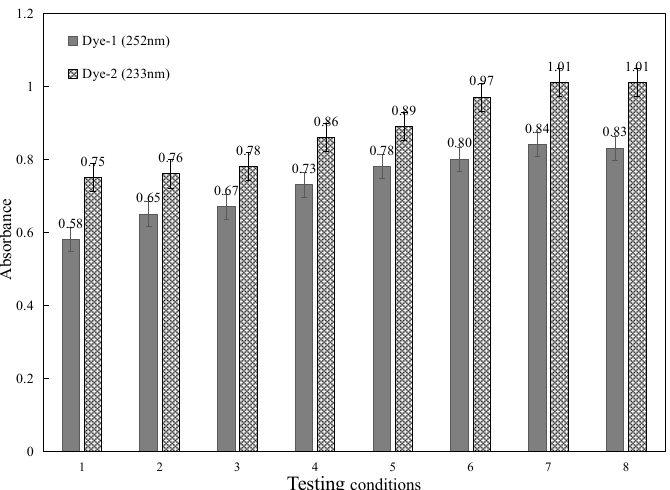
Figure 2. Detection of abs in simulated dyeing experiments. Please note: 1-Mixing of 0.0005 mol dye and 0.0005 mol n -butanol at room temperature. 2-Reaction of 30 min with reaction solution 1 at room temperature. 3-Put the 2-reaction solution into a water bath heated to 60 °C and reacted 15 min. Divided the reaction liquid of 3 into 5 parts. The pH was adjusted to 6, 7, 8, 9, 10 with sodium carbonate labeled as 4, 5, 6, 7, 8, then reacted 45 min. The liquid after uniform mixing was taken for the process of UV detection, and the concentration was always same.